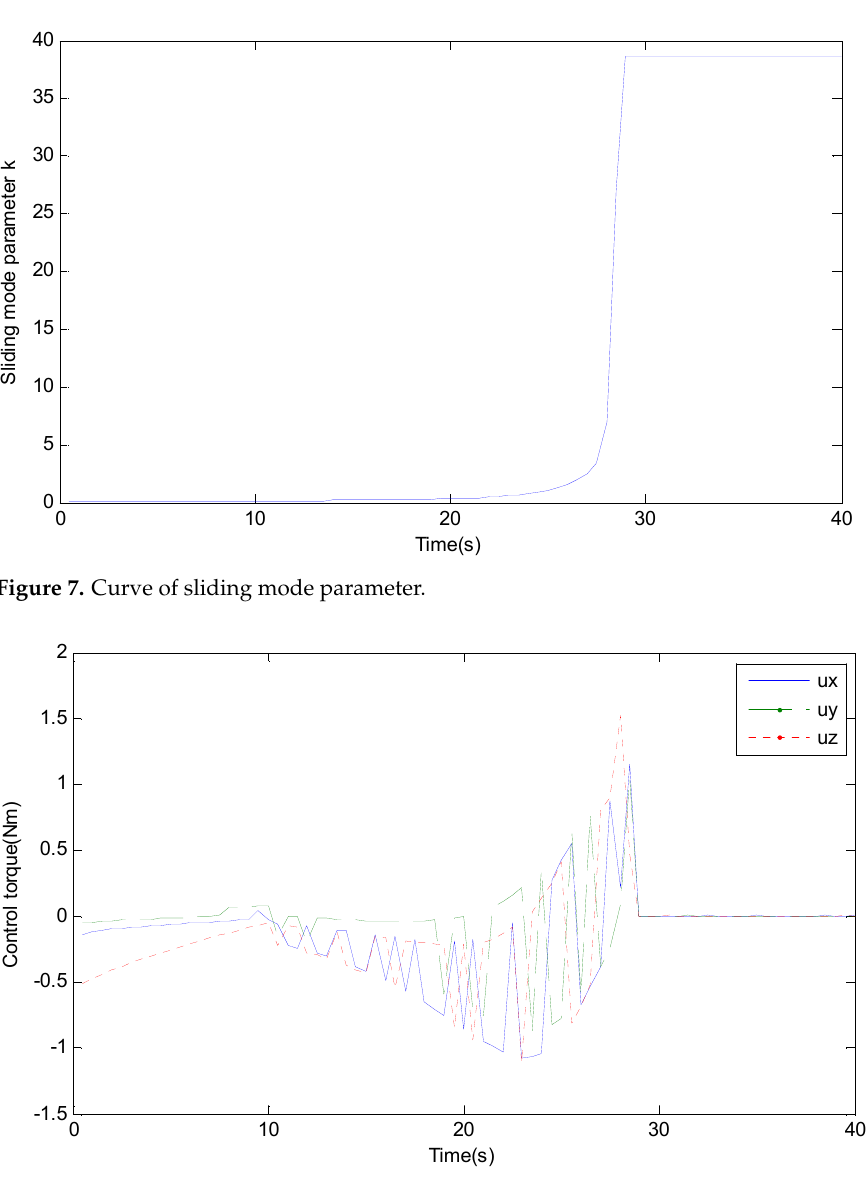
Figure 6. Curve of attitude quaternion.